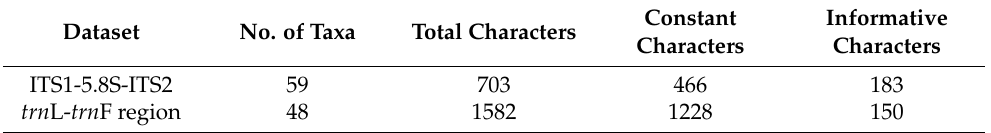
Table 2. Statistical data for each single